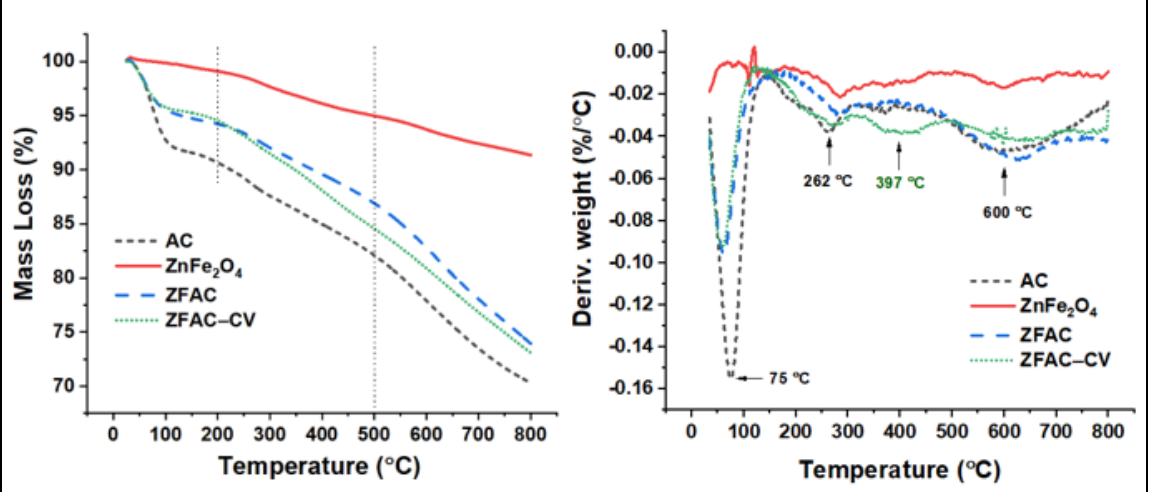
Figure 7. Thermogravimetric (TGA) thermograms (left) and their corresponding derivative (DTG) curves of AC, ZnFe 2 O 4 , ZFAC, and ZFAC–CV.